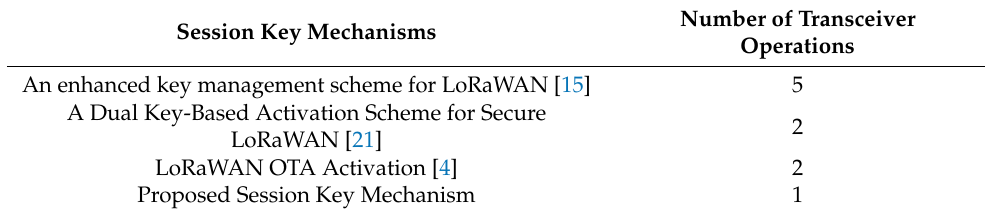
Table 4. Transceiver Operation Comparison with Existing Session Key